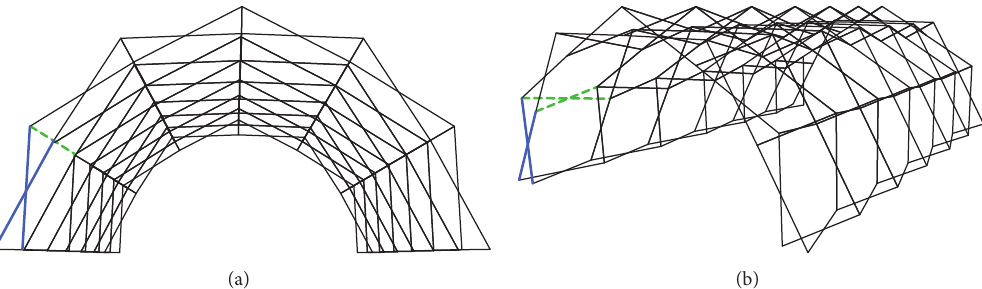
Figure 1: A barrel vault structure is composed of arches with polar units (blue bold solid line) connected through translational units (green bold dashed